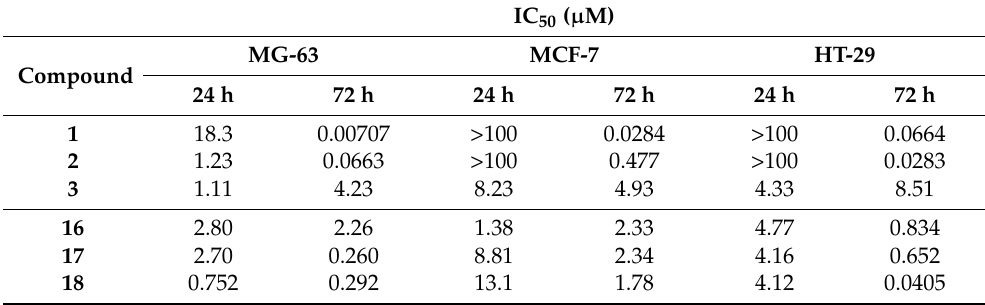
Table 1. Cytotoxicity values (IC 50 , µ M) of the precursors 1 – 3 and final hybrids (L-MHQs 16 – 18